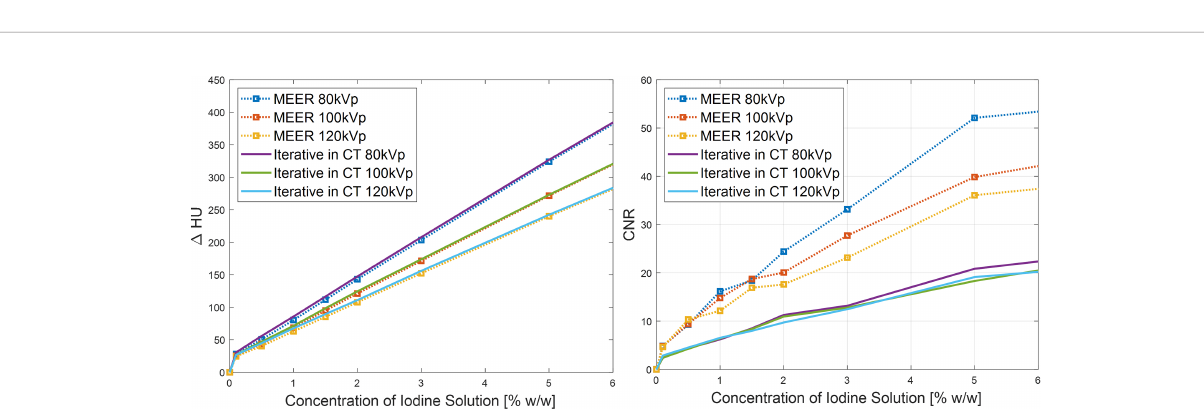
FIGURE 8 | Comparison of CNR (left) and contrast enhancement (right) between MEER-CBCT and images reconstructed by iterative algorithm with each energy channel independently in simulation study.